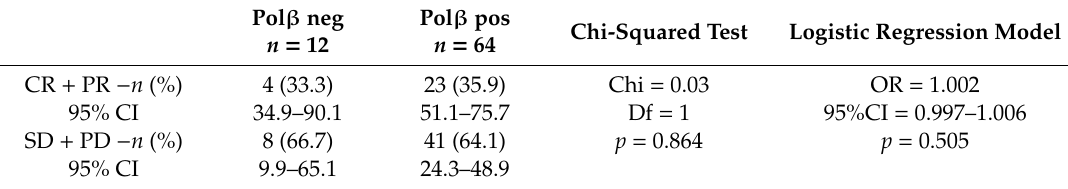
Table 4. Objective response rates by DNA Polymerase β H-score (Pol β ). CR, complete response; PR, partial response; SD, stable disease; PD, progressive